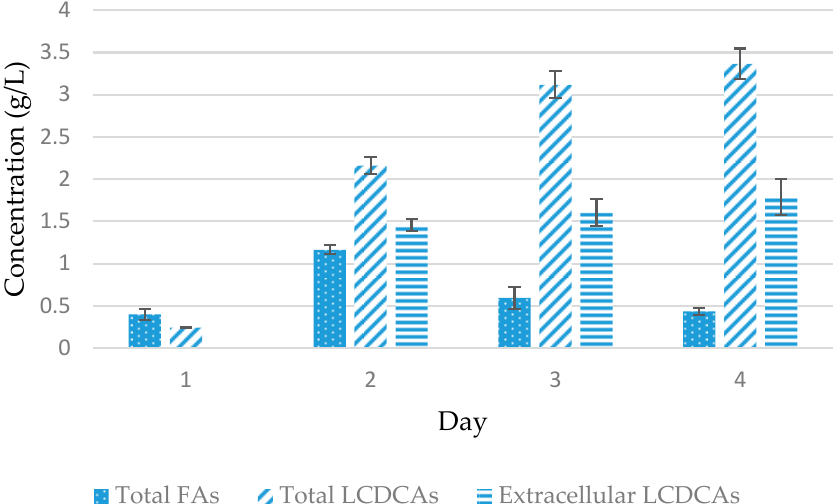
Figure 6. Time course study of total fatty acid, total LCDCA, and extracellular LCDCA production by the ML strains/treatment. Glycerol based media under nitrogen-limiting conditions (C/N = 50). Data from 2 rounds of batch fermentation. ML: ∆ POX1 -6 ∆ LEU2 ∆ SNF1 ∆ FAA1 ∆ LEU2::YlALK5 YlCPR YlFAO1 + YlALK5:: URA3 + 400 mg/L leucine. Total FAs: fatty acids of 16 and 18 carbons, Total LCDCAs: long chain dicarboxylic acids of 16 and 18 carbons. Data from 2 rounds of batch fermentation.